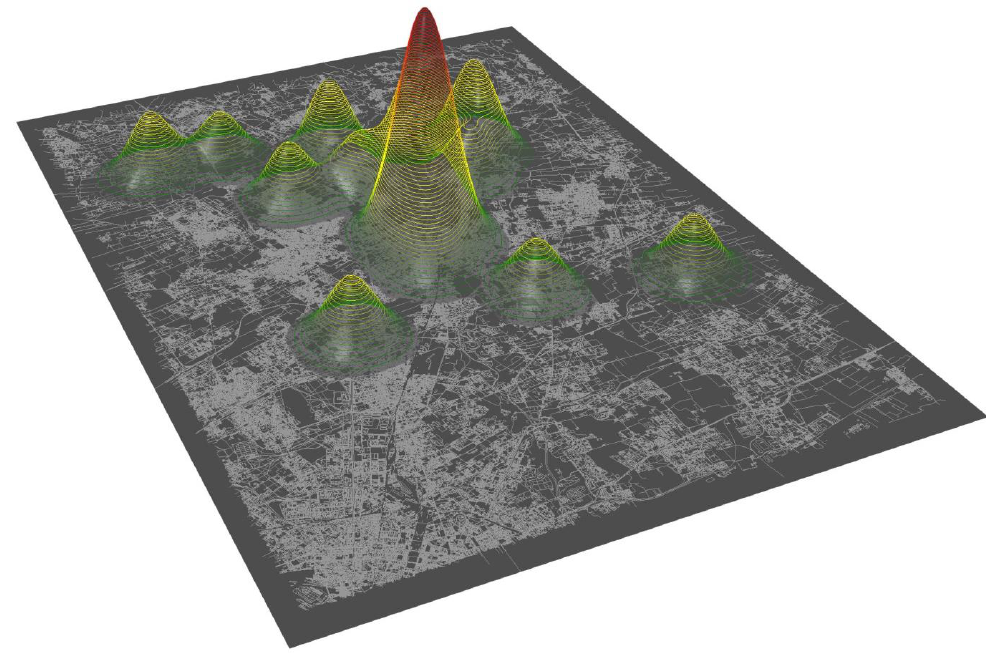
Figure 5. Tweets mapping dated 25th